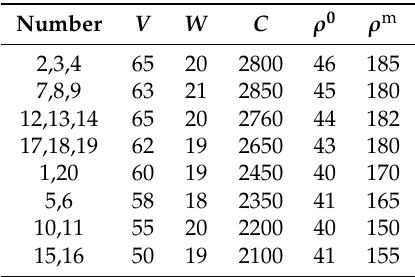
Table 3. Road segments